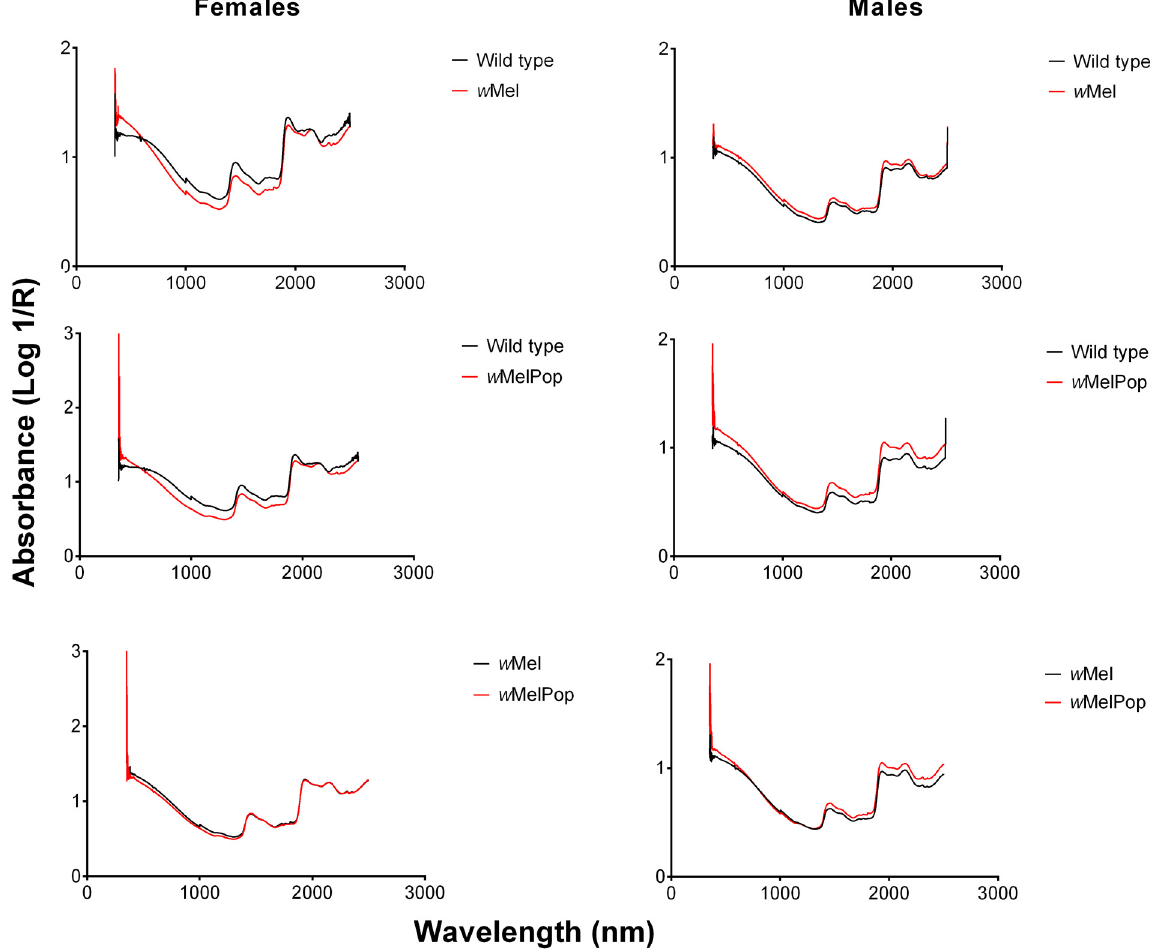
Fig 1. Examples of average spectra collected from heads and thoraces of Wolbachia infected and wild type male and female Ae . aegypti mosquitoes.